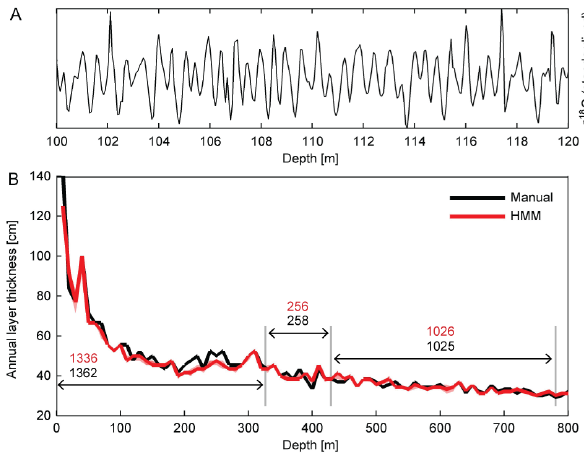
Fig. 6: (A) Example of the DYE-3 δ 18 O-record. The data was measured with approximately 8 samples per year. (B) Evolution in mean layer thicknesses for the upper 800 meters of the record, spanning approximately the last 2000 years (1979 - 79 CE). Annual layer thicknesses are calculated over 10 m sections. The 95% confidence interval derived for the automated counting is shown as a (very narrow) red shaded band. Uncertainties for the manual counting are negligible. The depth of three historically dated volcanic reference horizons (Öraefajökull, Hekla, Vesuvius) are indicated with grey bars. Red numbers denote automated layer counts within each section, which are to be compared to the historically known time durations (given in black).